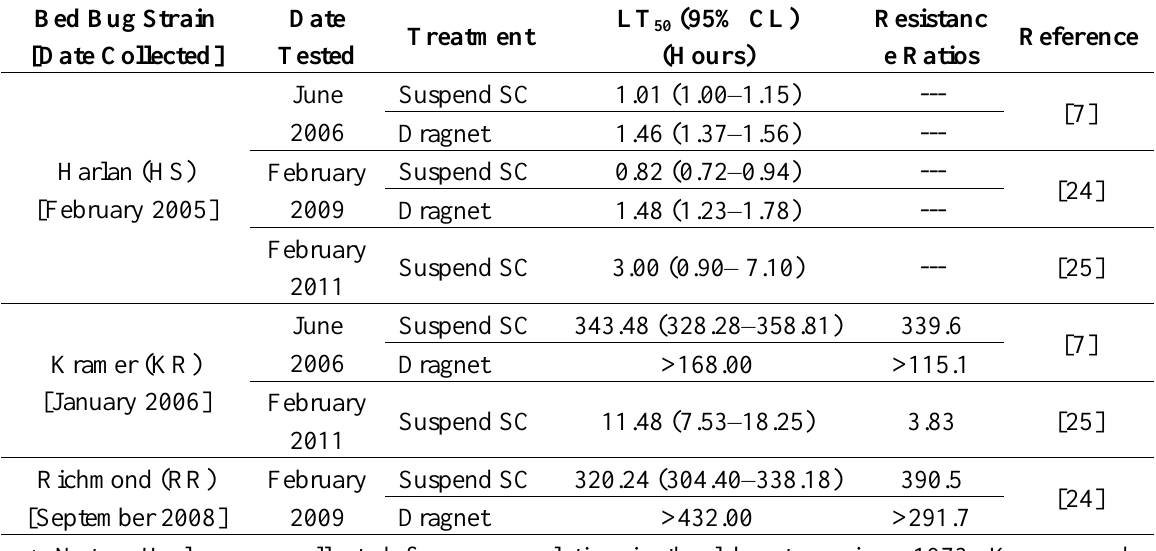
Table 1. Time to mortality of adults from three strains of the bed bug, Cimex lectularius , bioassayed for resistance to pyrethroid insecticides